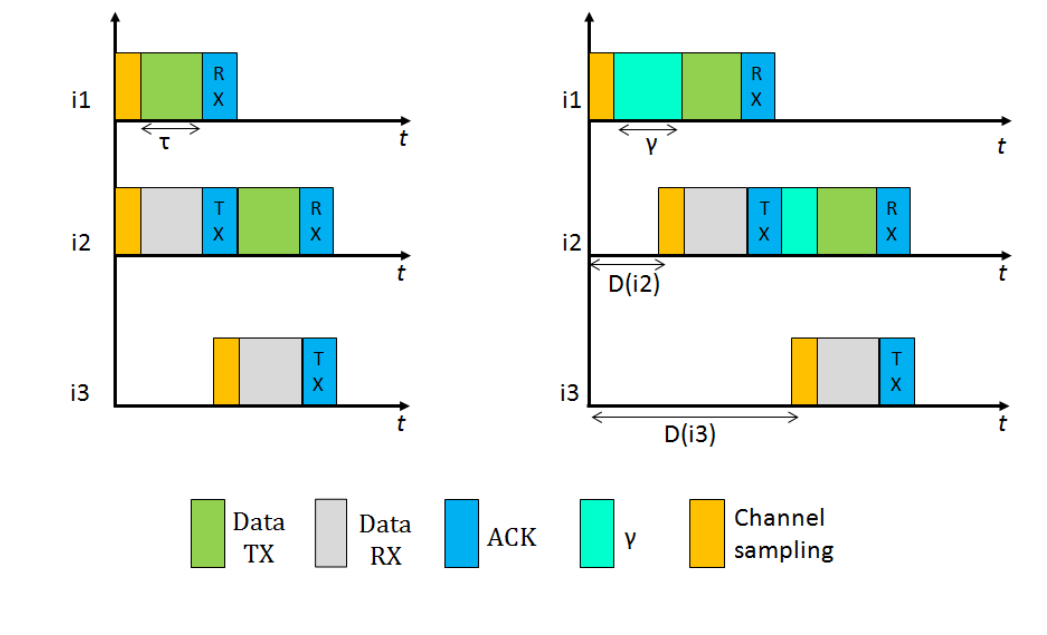
Figure 5. Behavior of CLAC in two different scenarios: on the left, the ideal case with no contention delays. On the right, a realistic case where delays are introduced at each hop. CLAC adjusts the next check interval in the receivers. In the figure (cid:28) stands for the time of transmission/reception of a packet of length s on the